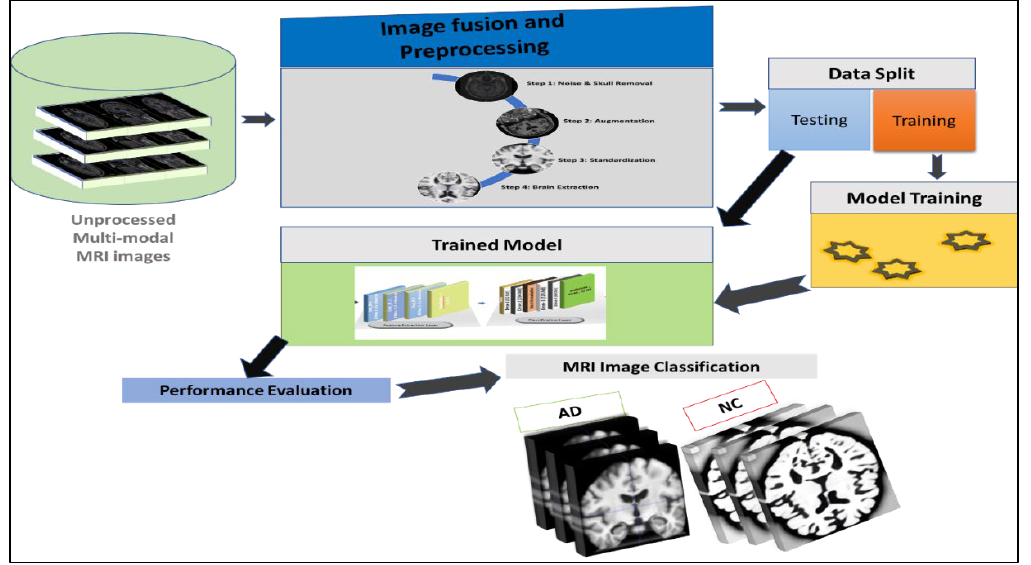
Figure 2. Proposed MULTforAD multimodal image fusion method for AD diagnosis framework.